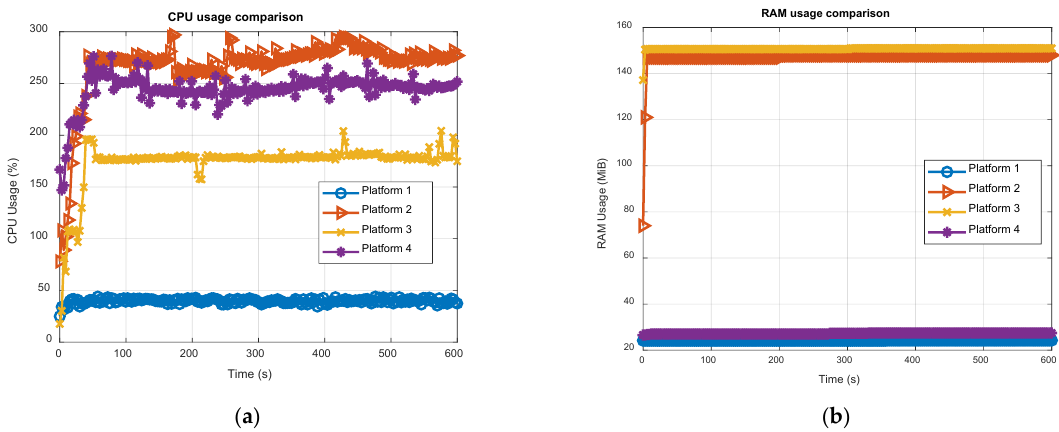
Figure 8. Time evolution of the CPU ( a ) and RAM ( b ) usage of eNGene receiver on the four platforms for 12 satellites, i.e., 6 GPS and 6 Galileo, simultaneously tracked.